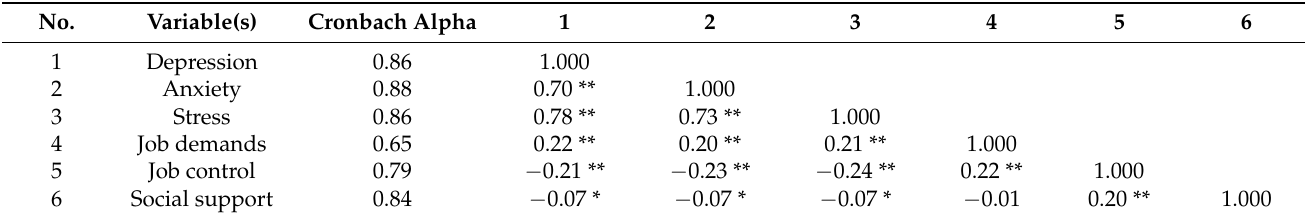
Table 6. The results of correlation between all studied variables.